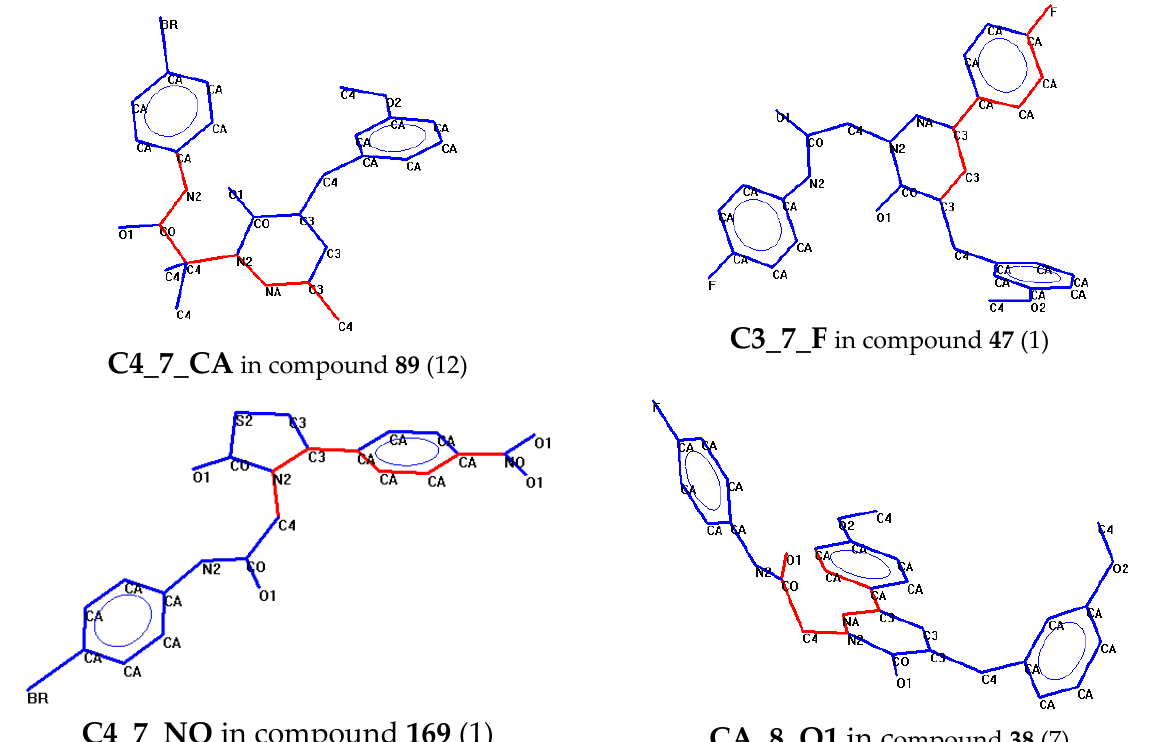
Figure 5. Examples of molecular structures with atom pairs corresponding to C4_7_CA, C3_7_F, C4_7_NO, and CA_8_O1 that were used for predicting the inhibition of the LPS-induced NF- κ B activity. One atom pair for each structure is highlighted in red and the total occurrence of the atom pair of a given type is indicated in parentheses. The notation of the atom types is as follows: CA, aromatic carbon; C3, olefin-type or imino carbon; C4, tetrahedral sp3-hybridized carbon; CO, carbonyl carbon; NA, pyridine nitrogen; N1, nitrogen in nitro group; N2, amino-, amido-, or imino- nitrogen; O1, carbonyl or nitro oxygen; O2, two-coordinated alcohol or ether-type oxygen; BR, bro- mine.